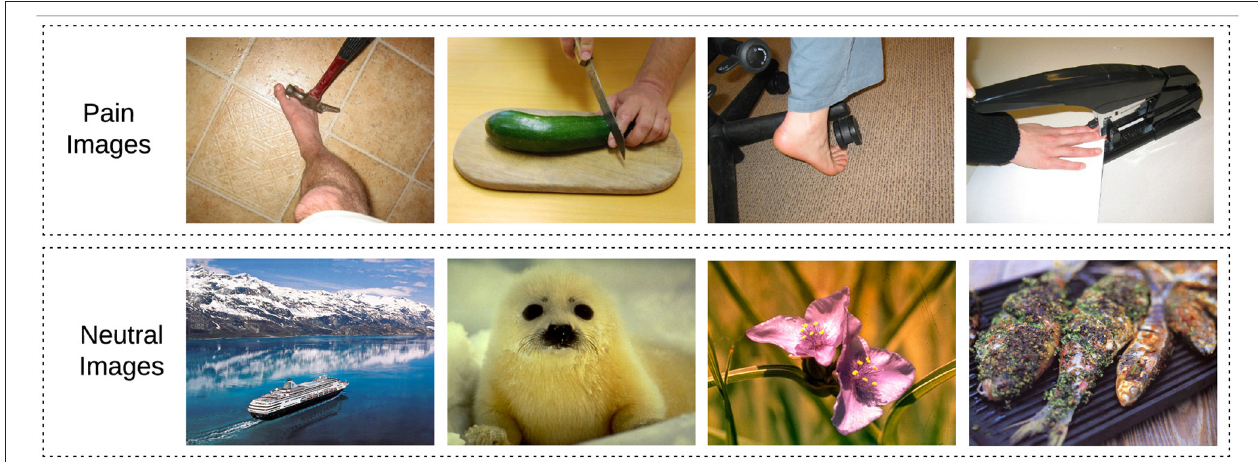
FIGURE 2 | Picture stimuli used in the localizer and neurofeedback tasks. Top row: examples of painful situations that can occasionally happen in daily life (23, 24). Bottom row: example of neutral pictures (25).